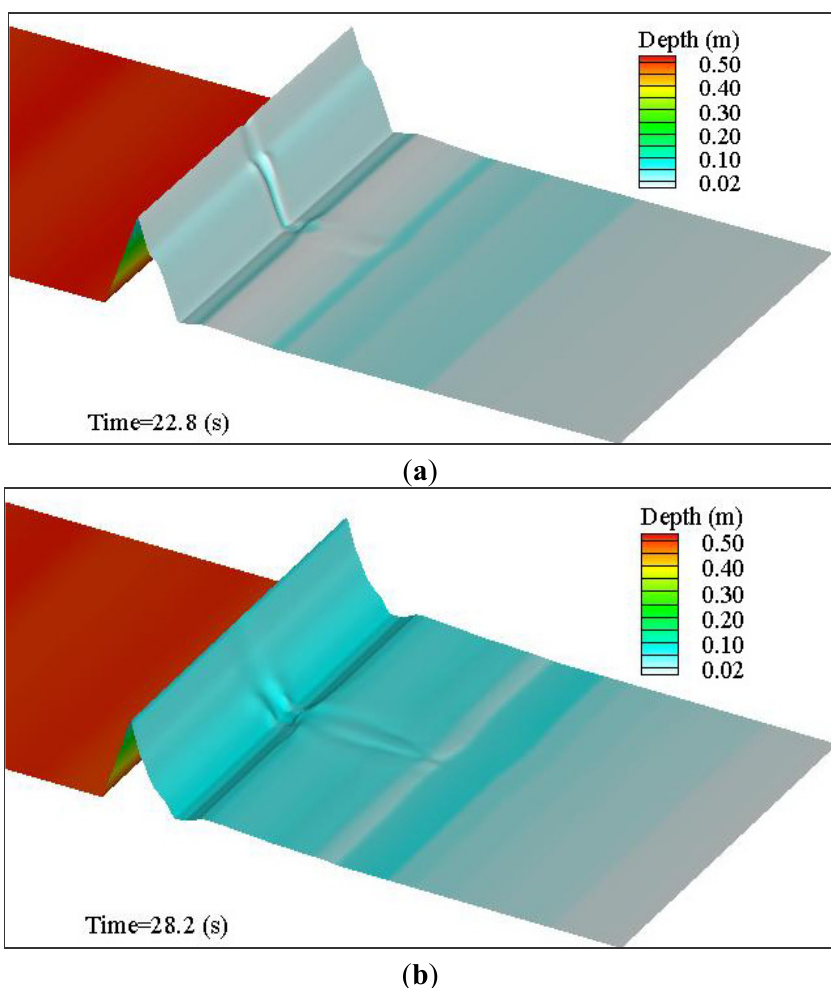
Figure 12. Bed changes and water depths with a wave at different times. The simulated water depths are plotted in the colored contours in the 3D topography view: ( a ) bed elevation and water depth at 22.8s, the sandy dam was eroded along the entire length and sediment was deposited in the downstream; ( b ) bed elevation and water depth at 28.2 s, the height of the dam was reduced quickly and erosion in the lower part of the dam downslope was